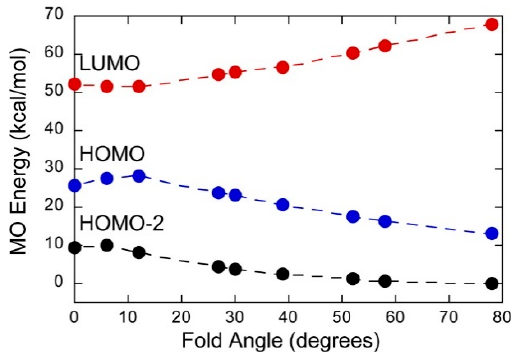
Figure 9. Frontier orbital energies as a function of fold angle in Mo IV O(SPh) 2 ( i Pr 2 Dt 0 ), which possesses a dithione π -acceptor ligand. (Adapted with permission from Inorganic Chemistry , 2016, 55, 785–793. Copyright (2016) American Chemical Society).